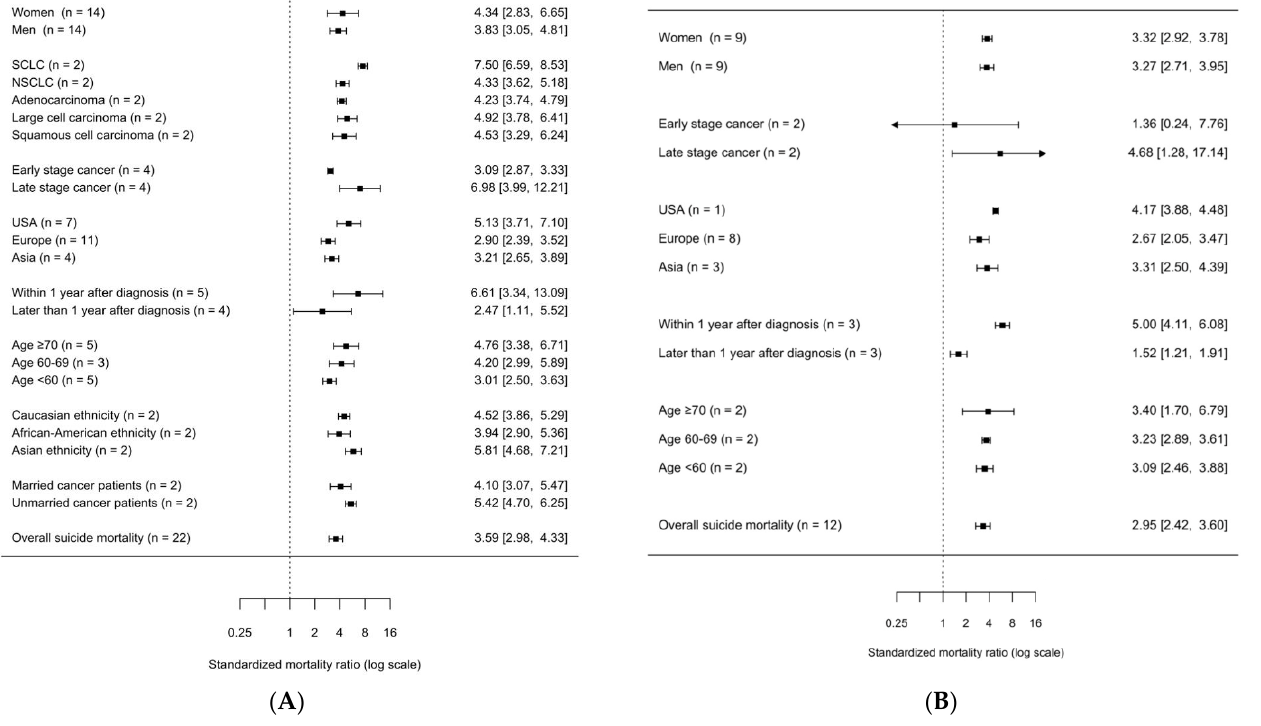
Figure 3. Comparison of overall and subgroup SMR of lung vs. all other cancer sites. Abbreviations: SMR, standardized mortality ratio; CI, confidence interval. Exact values of SMR and CI are indicated separately.